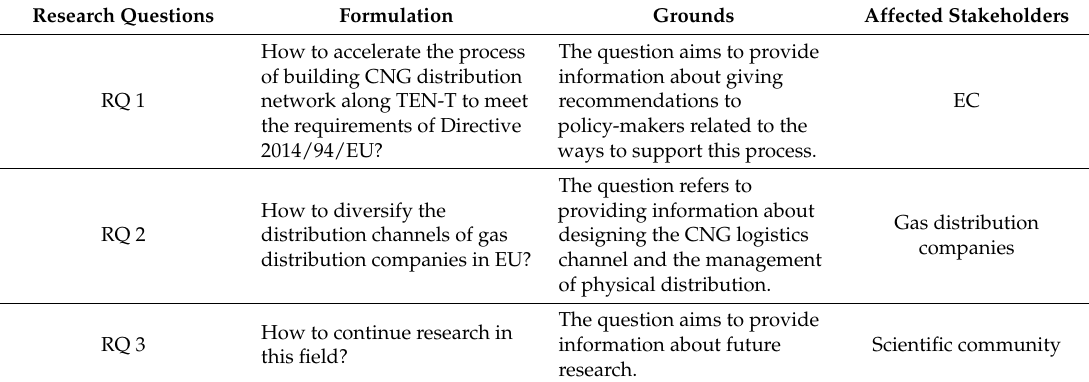
Table 1. Research questions